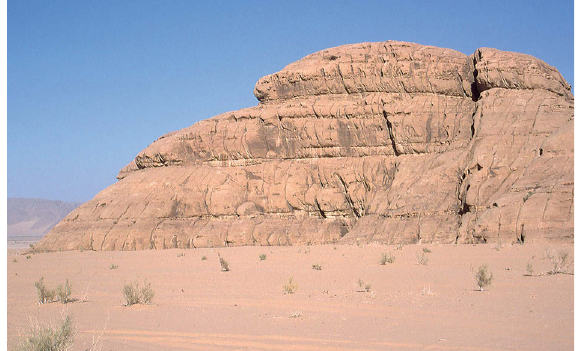
Fig. 2c. Example of sandstone rock slopes in south-west Jordan: rounded slopes of an inselberg built of the Disi sandstone, near Diseh